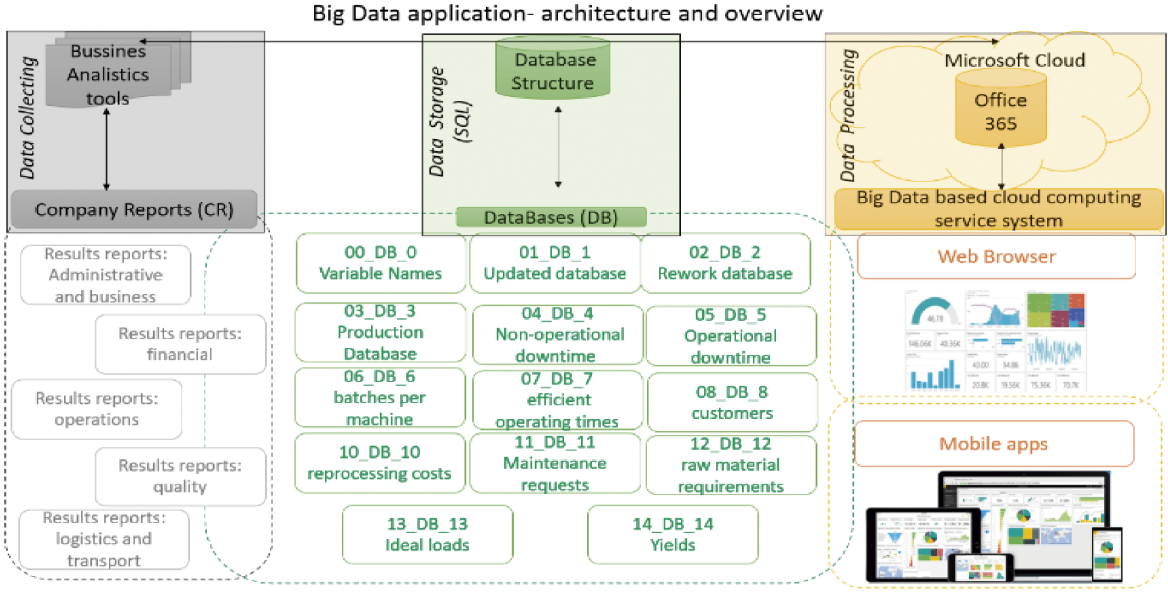
Figure 2. Big Data application-architecture and